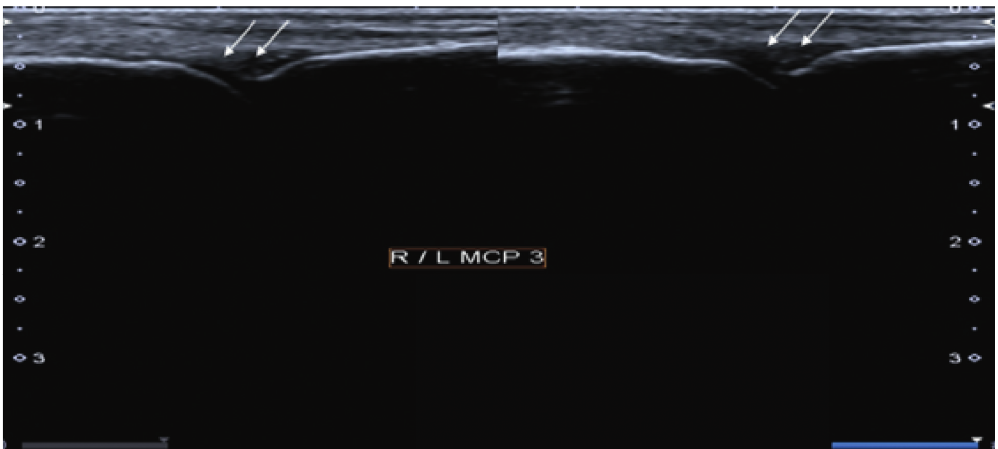
Figure 2: Grayscale images of bilateral 3 rd metacarpophalangeal joint demonstrating moderate synovial thickening (white arrows). The findings are consistent with Grade 2 synovitis.